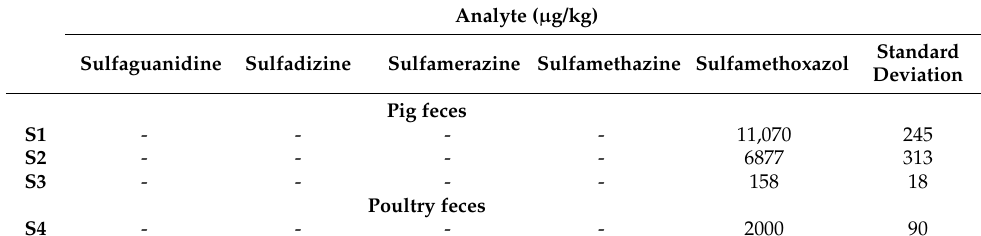
Table 3. The analytes and their concentrations detected in real samples.